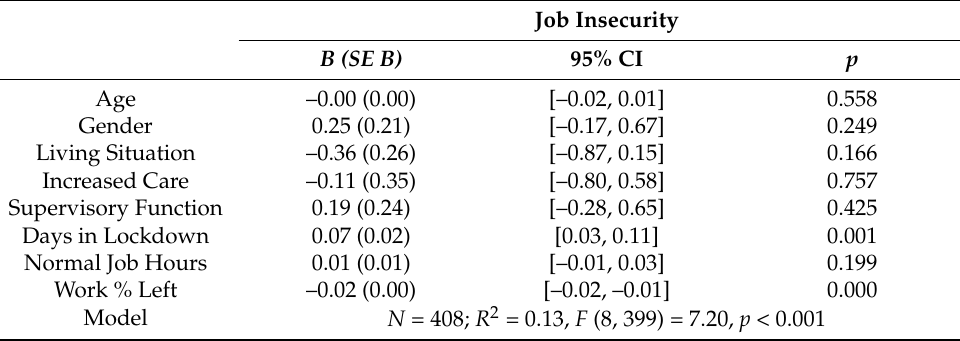
Table 6. Multiple regression analysis of work percentage left on job